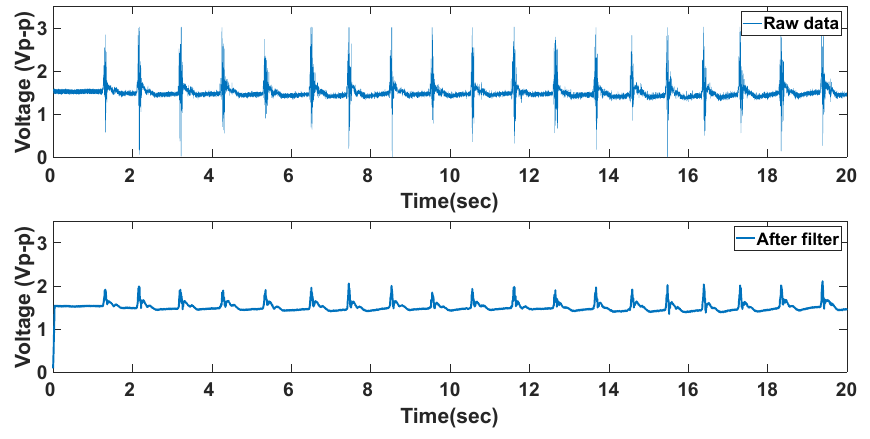
Figure 12. EMG filtering cross reference.